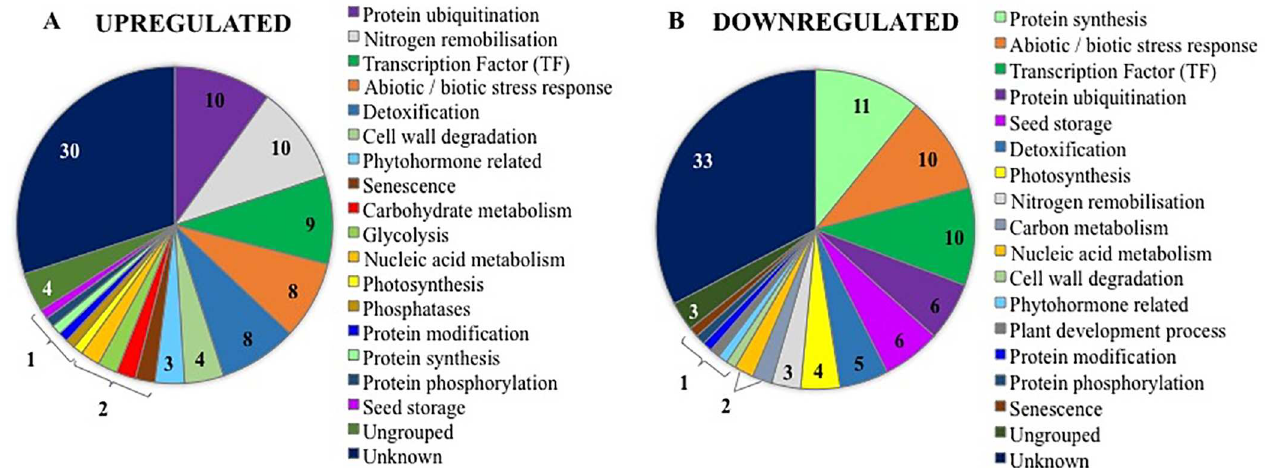
Fig 3. The 100 most highly upregulated (a) downregulated (b) in T16. The number in the chart indicates the number of genes that are assigned in the